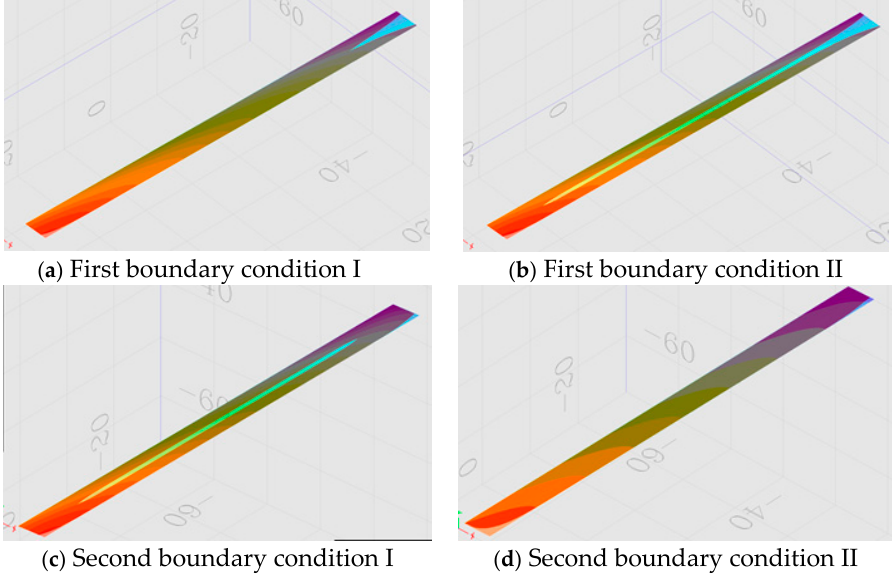
Figure 7. Head cloud diagram with two boundary conditions.